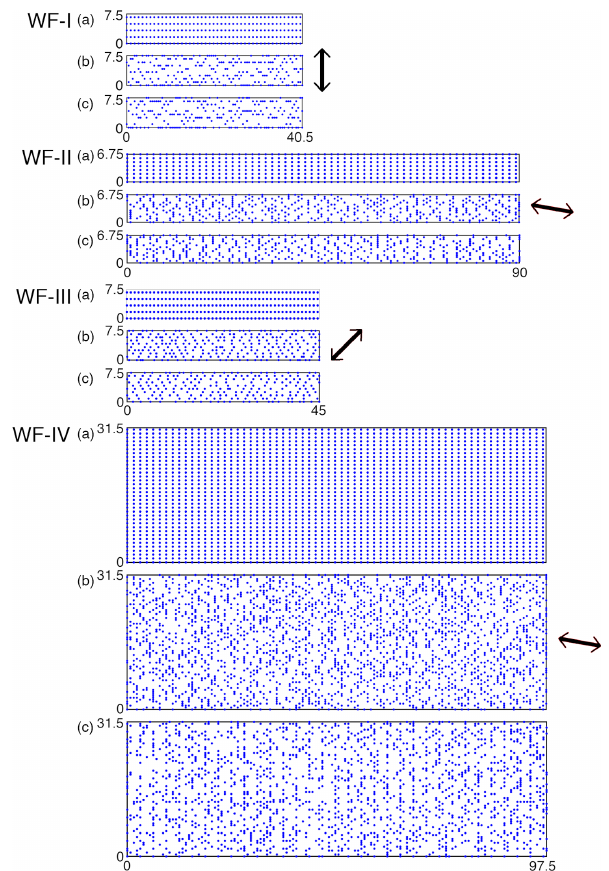
Figure 4. (a) Thumb rule, (b) OPTIMAL_F, and (c) OPTIMAL_V layouts for the four wind farms. The arrow depicts the dominant wind